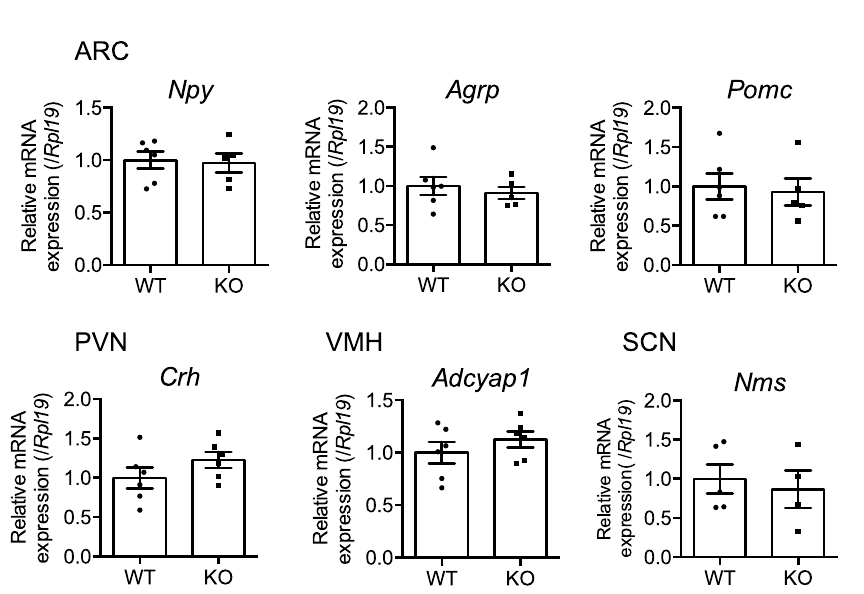
Figure 7. Expression levels of hypothalamic feeding regulatory hormones in male WT and NMU KO rats. Each brain region was collected by LMD. RT-qPCR analyses of Npy , Agrp , and Pomc were performed using ARC cDNA samples. RT-qPCR analysis of Crh was performed using PVN cDNA samples. RT-qPCR analysis of Adcyap1 was performed using VMH cDNA samples. RT-qPCR analysis of Nms was performed using SCN cDNA samples. All data represent means ± SEM (n = 6). See also Supplementary Figure S2 .See also Supplementary Table S1 for